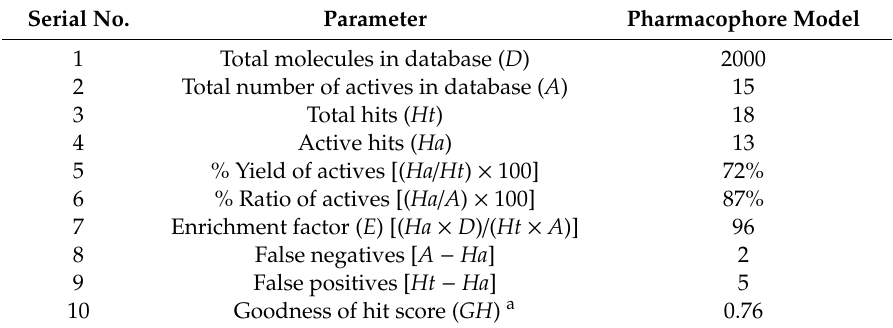
Table 1. Pharmacophore model validation by goodness-of-hit score (GH) score method. Serial No. Parameter Total molecules in database ( D